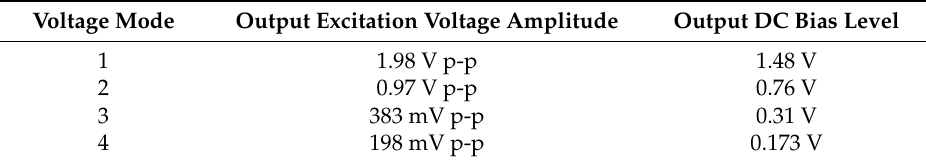
Table 2. Excitation voltage amplitudes and DC bias levels for a supply voltage of 3.3 V [24].